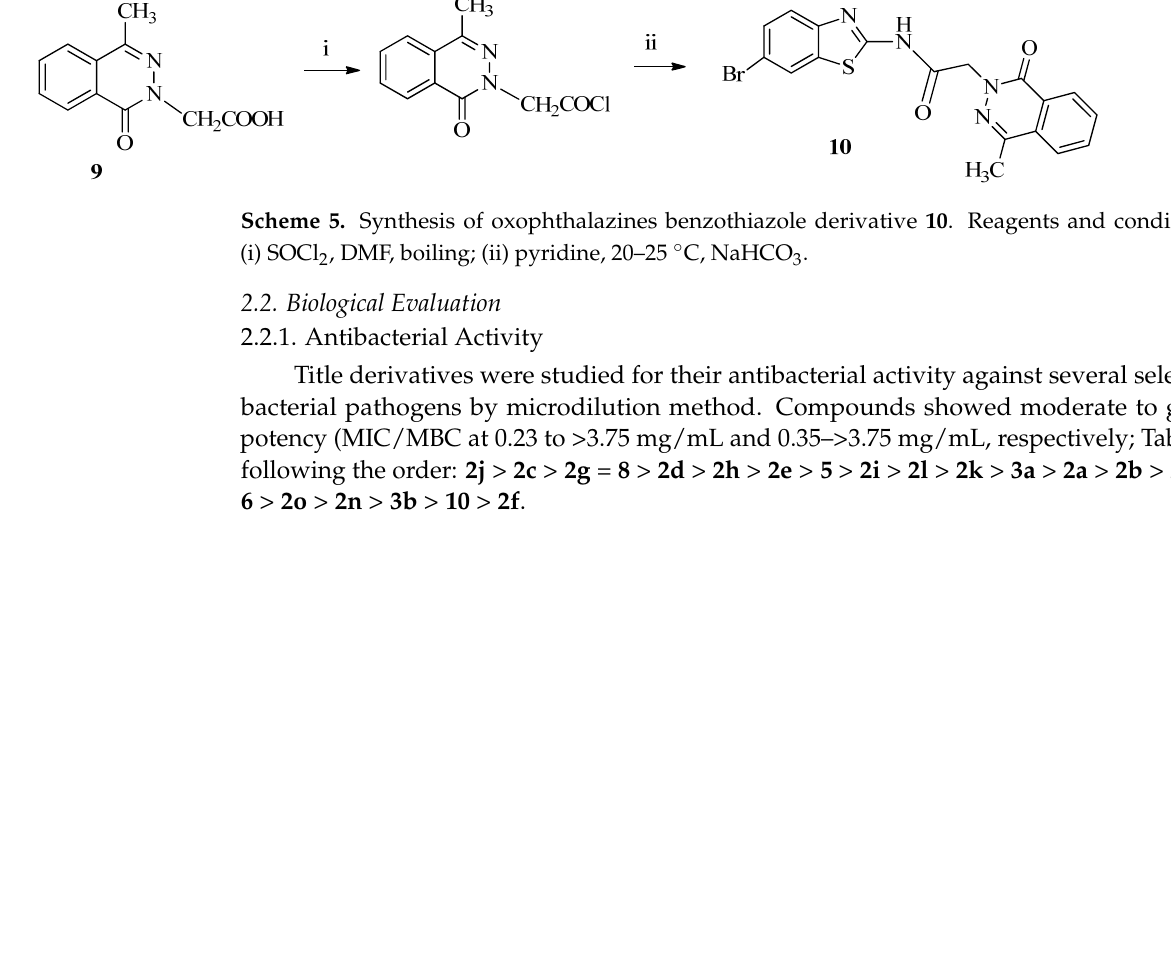
Table 1. Antibacterial activity of heteroaryl derivatives of benzothiazole (mg/mL).